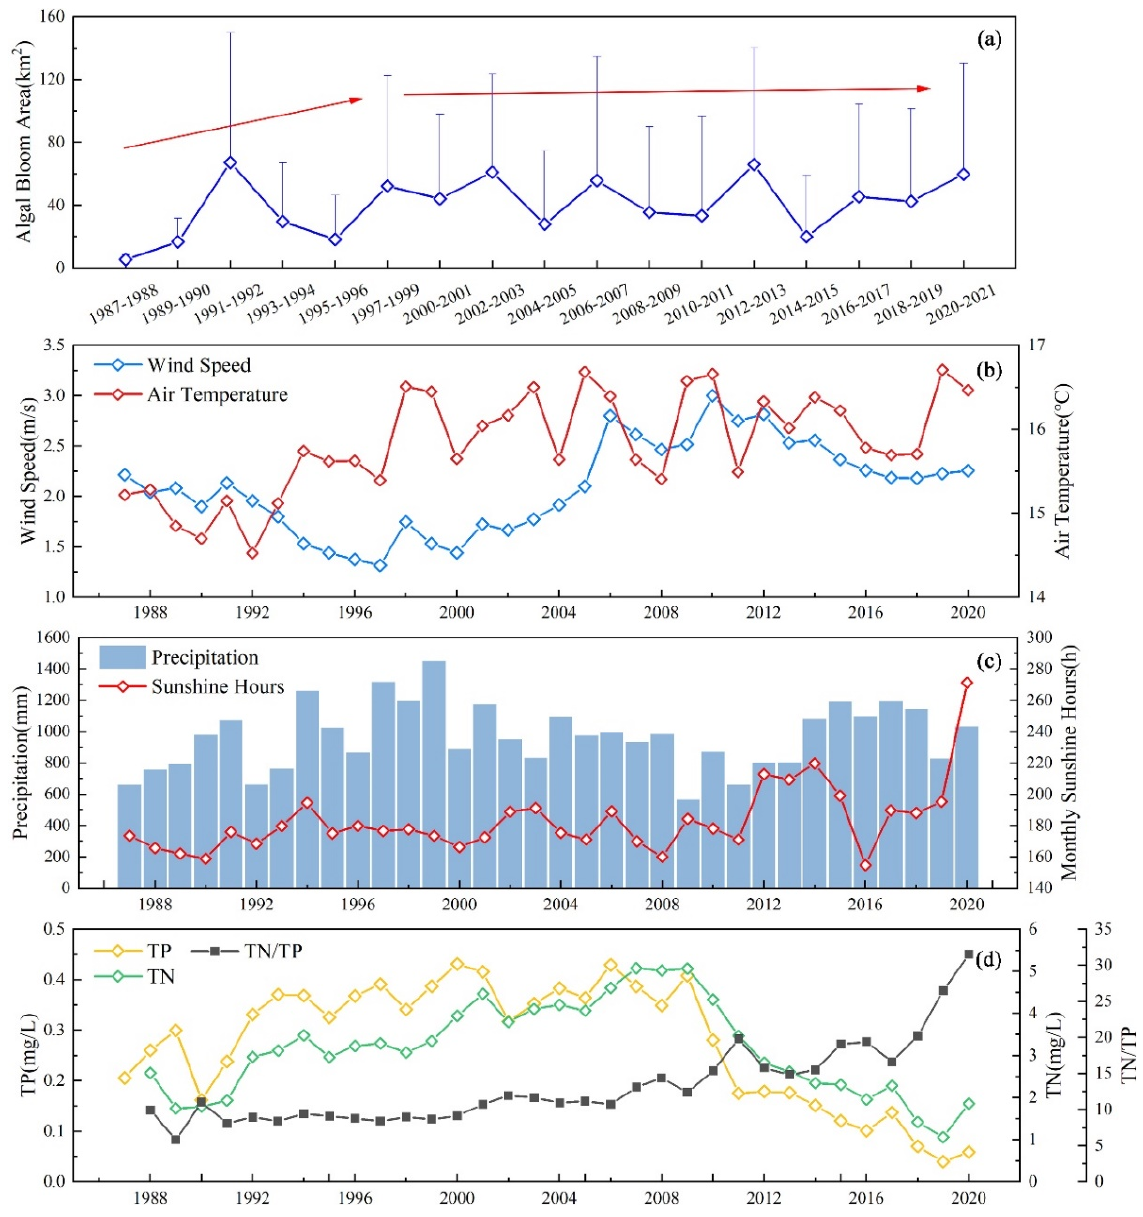
Figure 4. ( a ) Time series on a 2-year scale of the algal bloom area in Lake Dianchi between Landsat and MODIS/Terra (during 1987–2021). ( b ) Time series of the average wind speed and air temperature during 1987–2020. ( c ) Time series of the average precipitation and hours of sunshine during 1987–2020. ( d ) Time series of the average total nitrogen (TN), total phosphorus (TP), and N/P ratio (TN/TP) during 1987–2020.